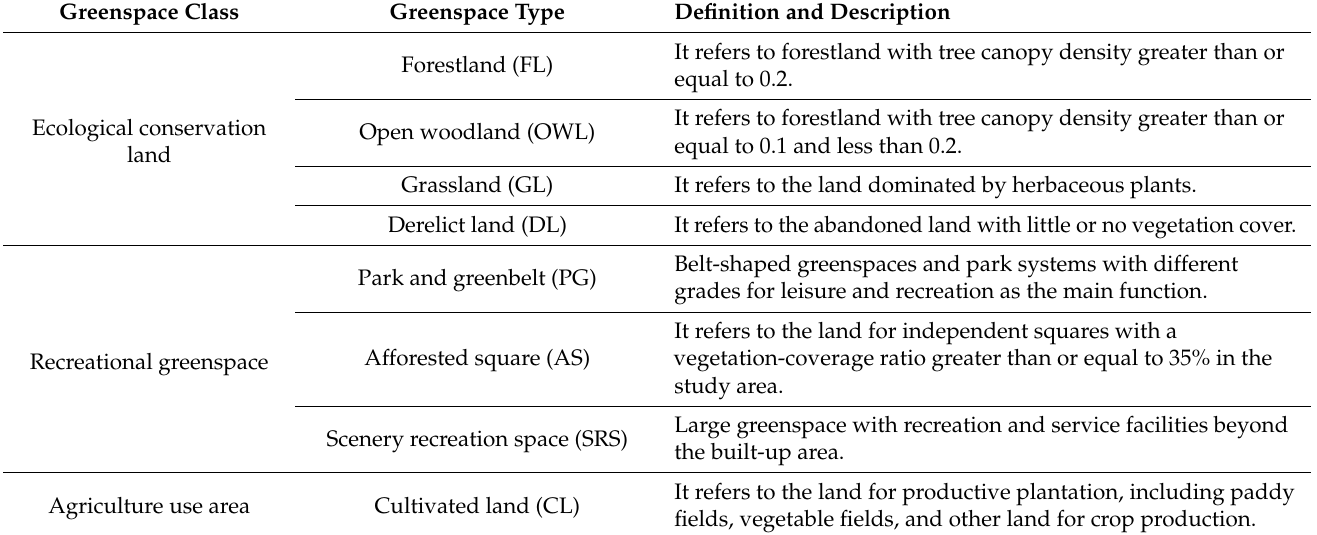
Table 1. Classification system of greenspace in the urban riverfront